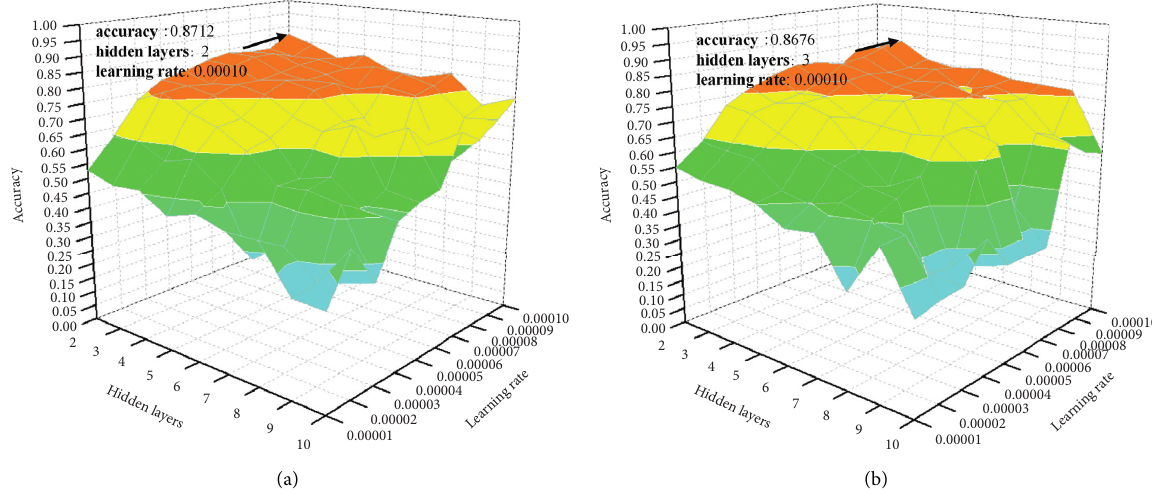
Figure 8: Determining the optimal hidden layers and learning rate of LSTM via a grid search in the validation